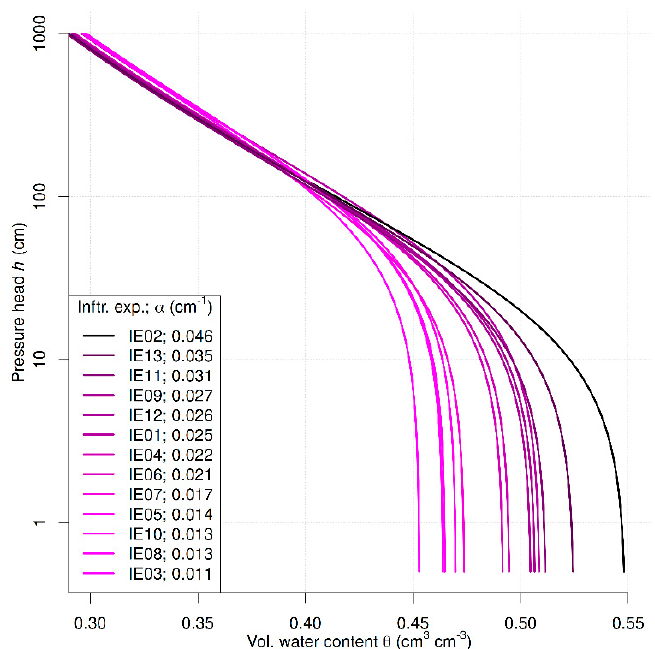
Figure 4. Scaled retention curves of fitted experiment-specific retention curves from individual infiltration campaigns.